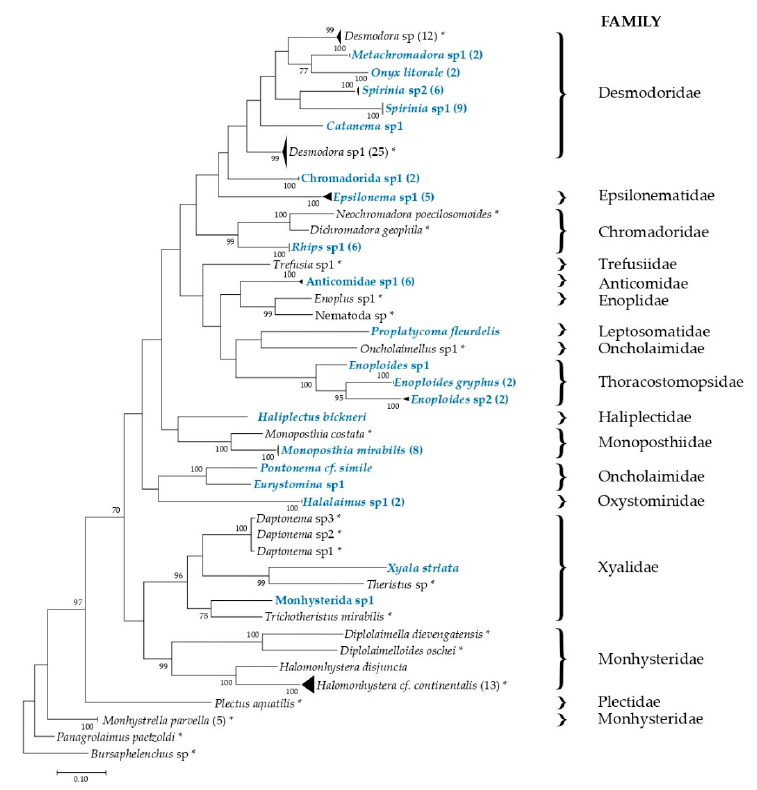
Figure 5. Maximum-Likelihood tree reconstructed from COI DNA sequences based on GTR+G+I model. Sequences of marine nematodes from the present study are annotated according to their morphological identification. The 20 haplotypes generated in this study are highlighted in blue color. Numbers in parentheses refer to the number of specimens sequenced. Reference of 70 sequences obtained from GenBank are indicated with an asterisk. Accession numbers are in Supplementary Table 1. Higher taxa (families) are indicated behind the line. Classification is based on Nemys database in www.marinespecies.org [12]. Arely Martínez 2020 ©